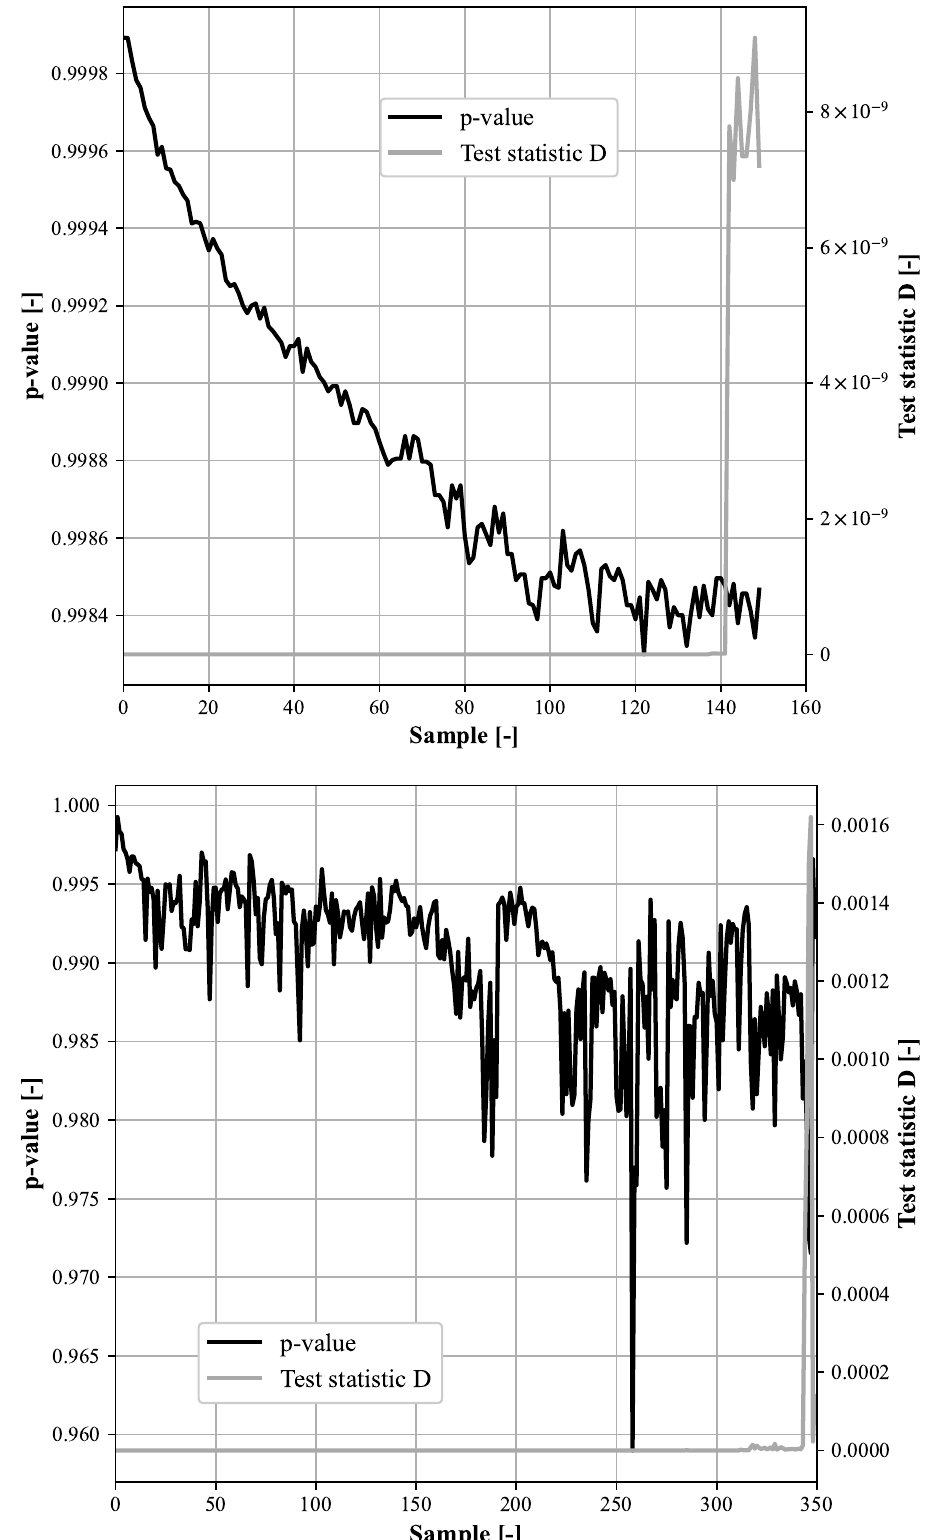
Figure A3. p -values and test statistics D for each sample of setup I ( Top ) and II ( Bottom